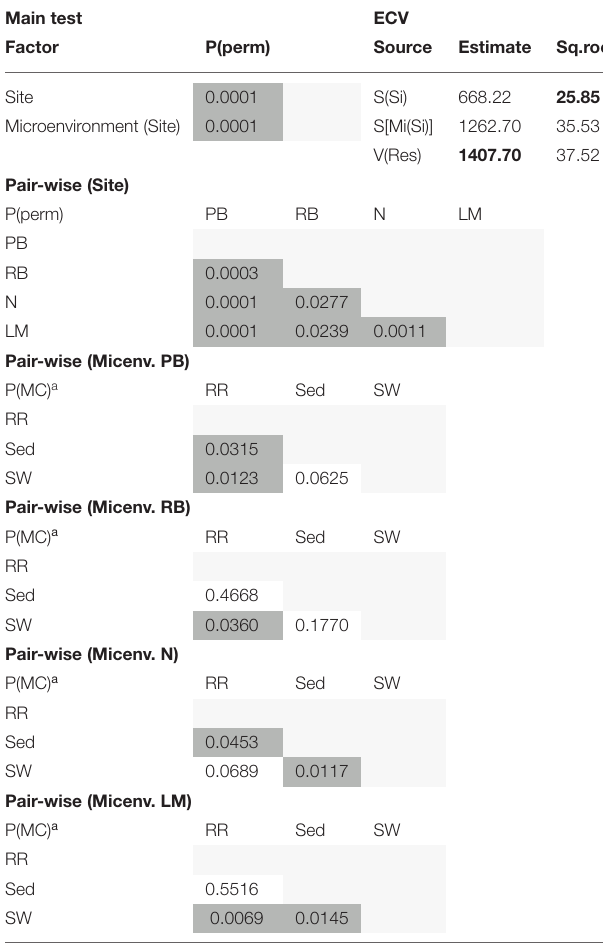
Differences between fungal communities across sites and microenvironments (top), betweensites(middle),andbetweenmicroenvironmentswithinsites(bottom)weretested forstatisticalsignificanceinPermutationalMultivariateAnalysisofVariance(PERMANOVA, Bray-Curtis dissimilarity matrix, nesteddesign). a Monte Carlo p-values used when there were not enough possible permutations (unrestricted permutation method, 9,999permutations). Significant values at the 0.05 level are shown ingrey. ECV, estimates of components of variation; RR, roots and rhizomes; Sed, sediment; SW, seawater; PB, Palm Beach; RB, Rose Bay;N, Narrabeen Lagoon; LM, Lake